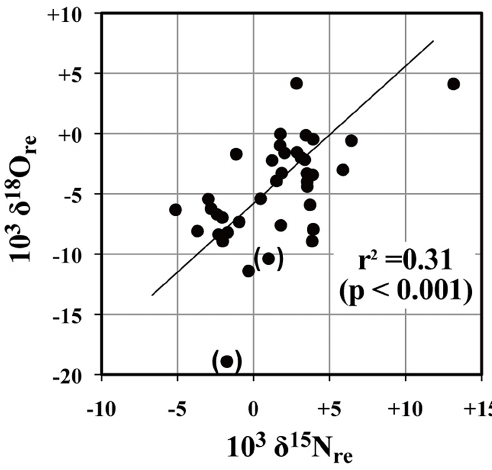
Figure 5. Relationship between estimated δ 15 N and δ 18 O of rem- ineralized nitrate in stream water samples ( δ 15 N re and δ 18 O re , re- spectively). See text for the detailed processes used to obtain the values. Data points obtained from samples with high 1 17 O values (> + 10‰) are shown in parentheses to indicate that they could in- clude large